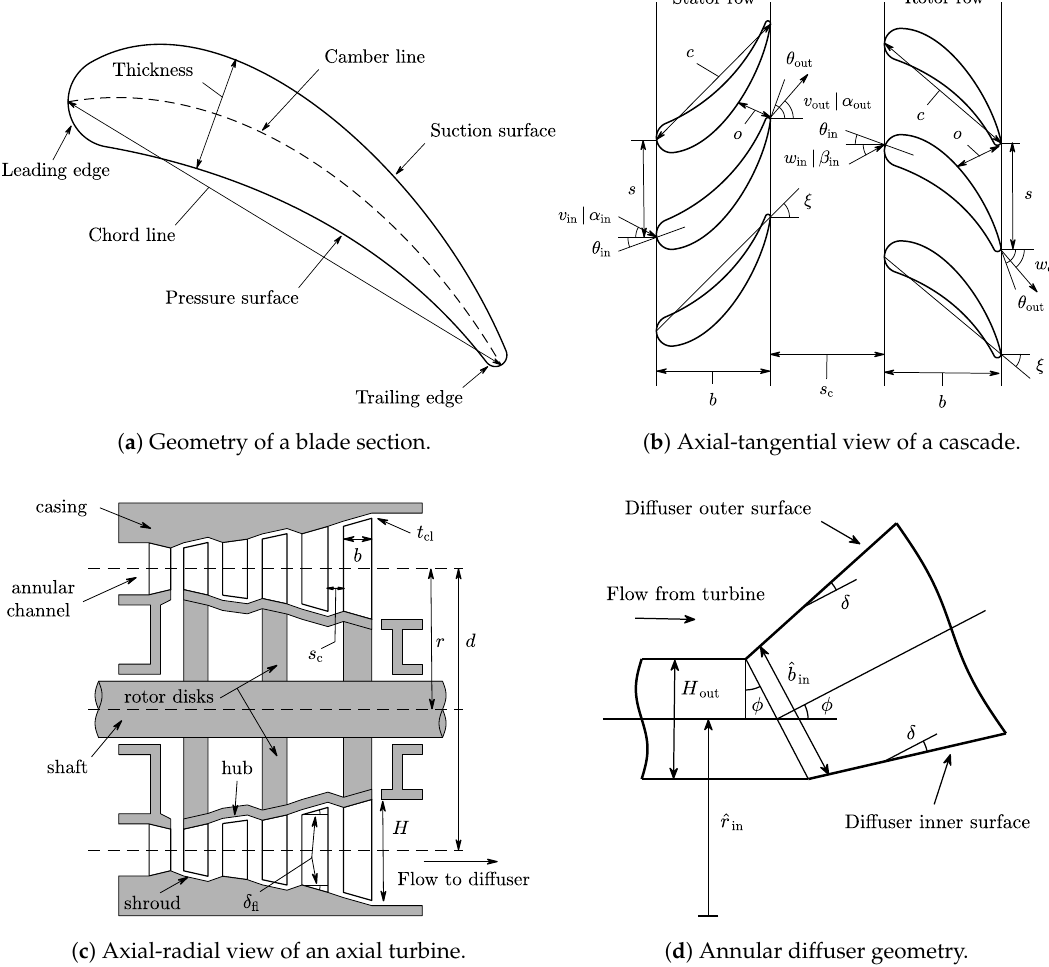
Figure 1. Geometry of a general axial turbine and exhaust